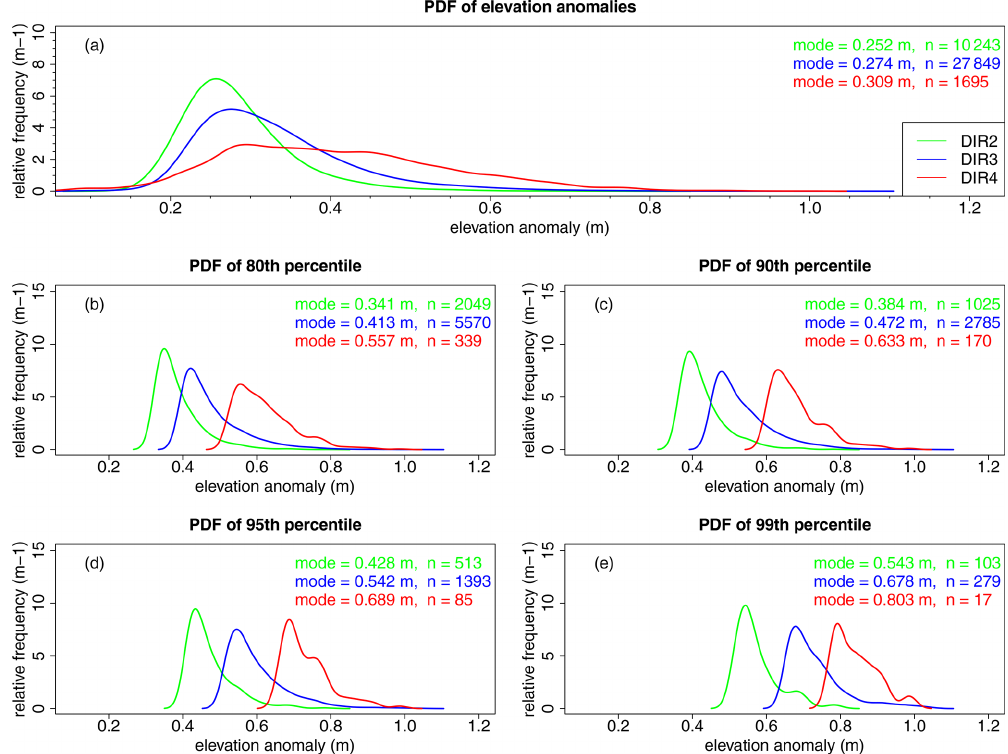
Figure 3. Distributions of elevation anomaly ( h a ) to estimate different degree of ice ridging (DIR) zones. DIR2, DIR3, and DIR4 are shown in green, blue, and red, respectively. (a) Distributions of h a of all segments; (b) distributions of 80th percentile values of N = 150-photon segments (the 20% highest values); (c) the 90th-percentile values (10% highest values); (d) 95th-percentile values (5% highest values); (e) 99th-percentile values (1% highest values). The modal value and number of included observations ( n ) for each distribution are provided in the